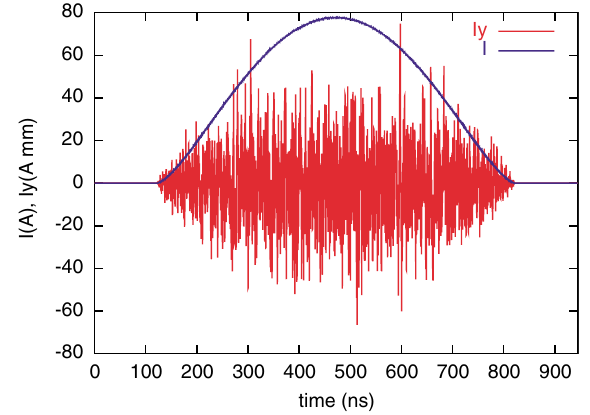
FIG. 23. (Color) Instantaneous current and dipole density for the 1000th turn of SNS simulation using parameters in Table